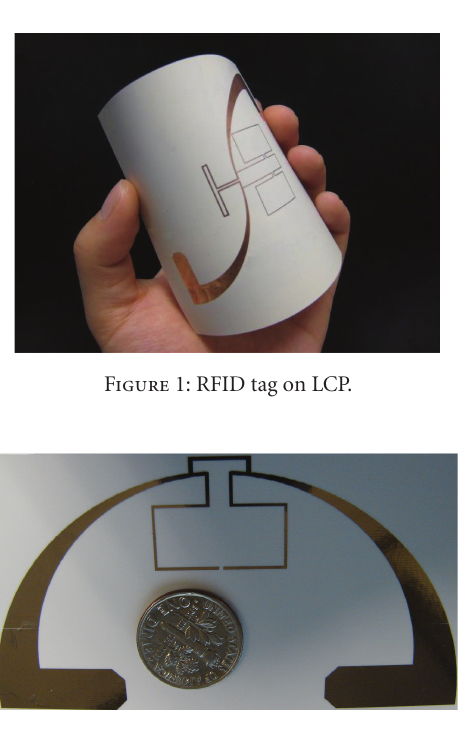
Figure 2: RFID tag on paper-based substrate.